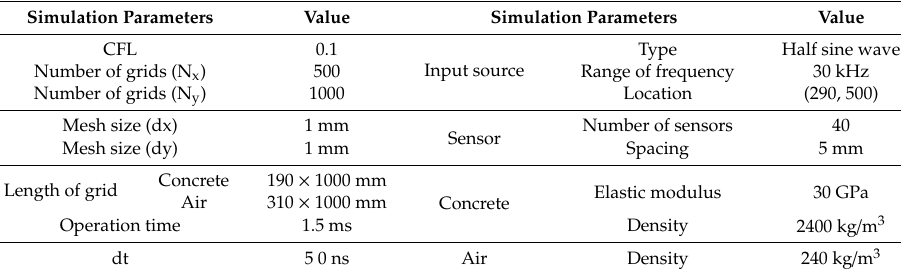
Table 1. Numerical simulation